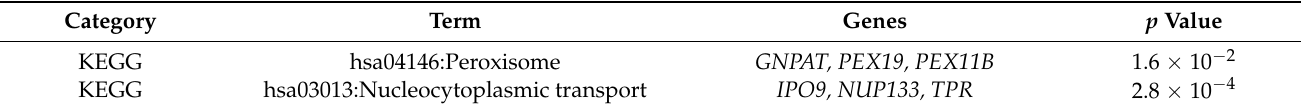
Table 1. KEGG enrichment analysis results for 36 genes in the minimal network.